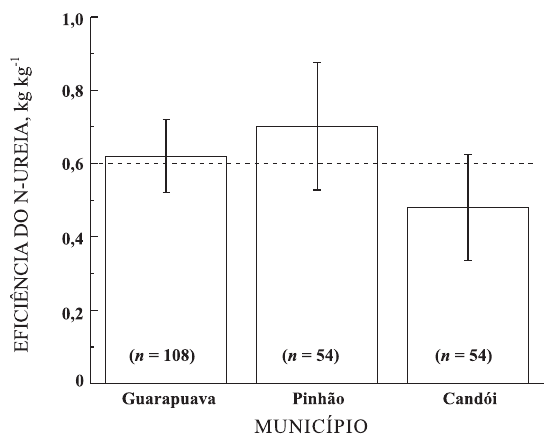
Figura 6. Eficiência do N aplicado em cobertura na forma de uréia (N absorvido por N aplicado). As barras verticais representam o intervalo de confiança estimado com o erro-padrão da média calculado a partir dos resultados da eficiência do N calculada em n